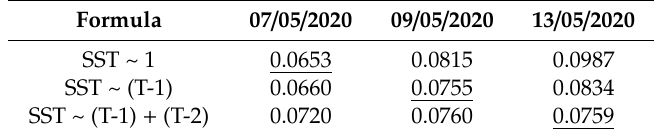
Table 1. Interpolation validation results from the MAE index. Best results are underlined.